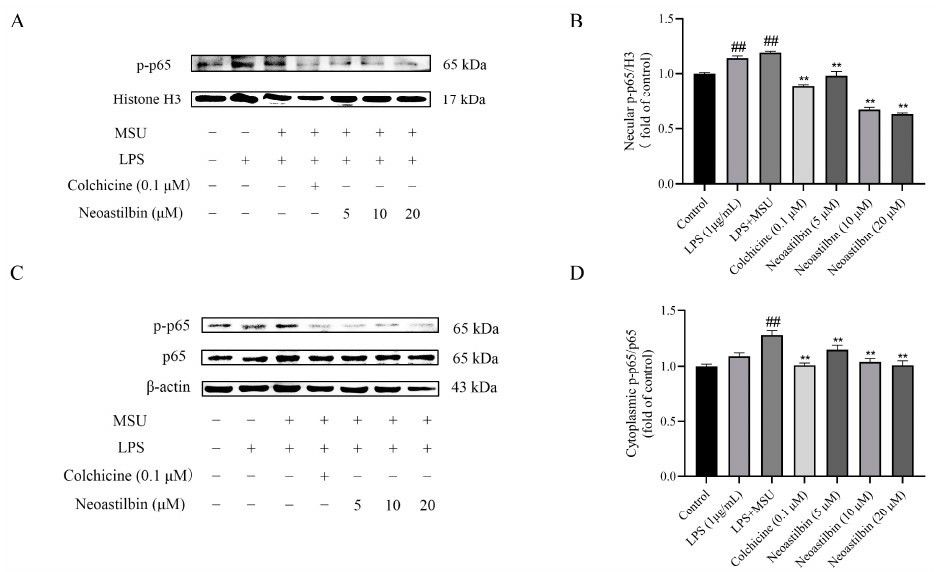
Figure 4. Effects of neoastilbin on protein expression of NF- κ B p-p65 in THP-1-derived macrophages. ( A ) The protein expression of p-p65 in the nucleus. ( B ) The ratio of protein expression of p-p65/H3 in the nucleus. ( C ) Phosphorylated and non-phosphorylated expressions of p65 in the cytoplasm. ( D ) The ratio of protein expression of p-p65/p65 in the cytoplasm. Data in the figures represent the means ± SD; significant differences among different groups are indicated as ## p < 0.01 vs. control group, ** p < 0.01 vs. LPS + MSU group ( n =